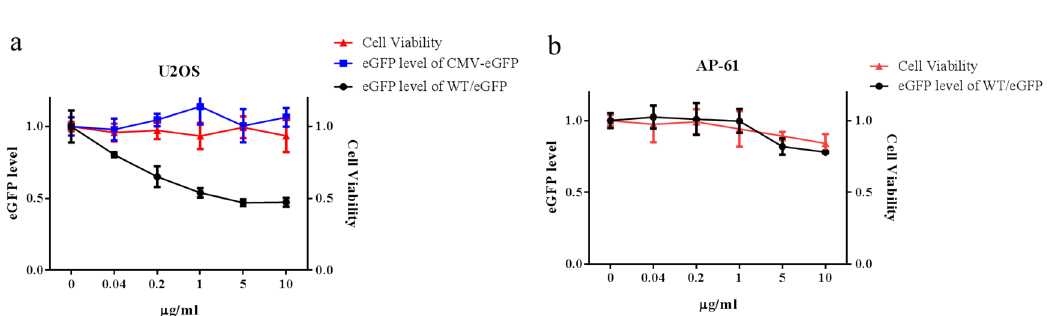
Figure 4. Characterization of autonomous CHIKV replicon using IFA. AP-61cells were transduced with W/ eGFP at MOI of 0.5. At 4 dpt, cells were fixed and co-stained with Mab anti-eGFP antibodies, rabbit anti- CHIKV nsP1 serum, and Hoechst 33342 (upper panels), or co-stained with Mab anti-dsRNA, rabbit anti- CHIKV nsP1 serum, and Hoechst 33342 (lower panels). Merged figures of the three are displayed in the right panels.